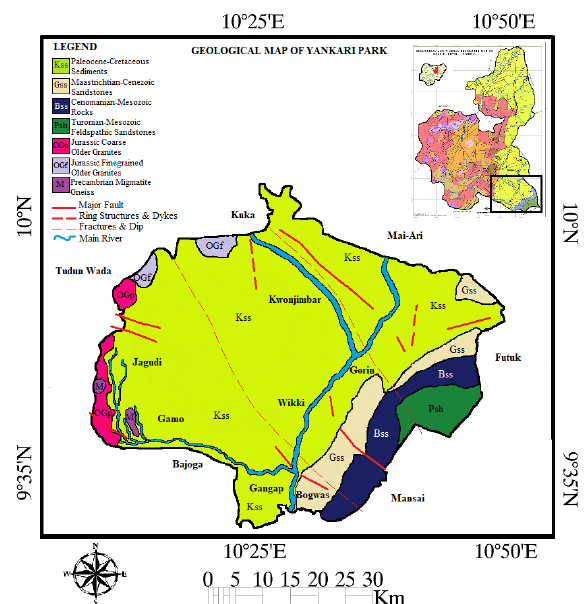
Figure 1. The study area geology map of Yankari Park showing region (A) location where analysis is conducted on ASTER and Hyperion